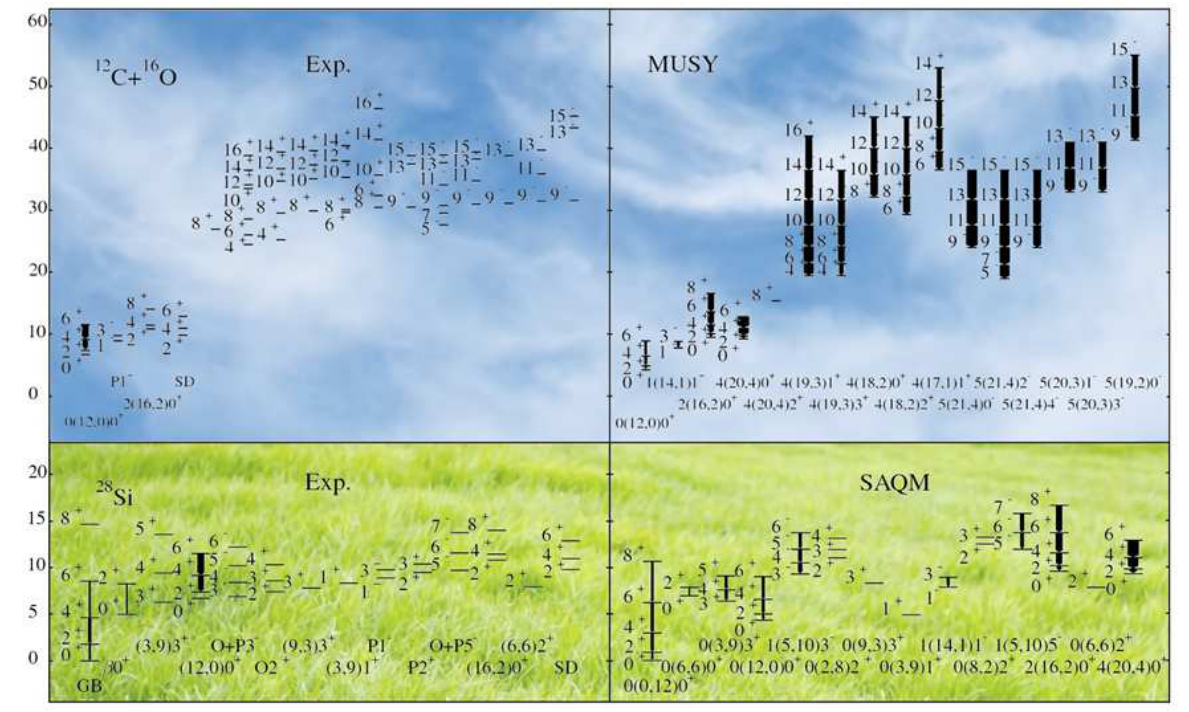
Figure 2. (Color online) Description of the low-energy bands of the 28 Si nucleus in terms of the semimicroscopic algebraic quartet model (lower part in the grass field), and the prediction of the MUSY for the 12 C + 16 O cluster spectrum (upper right part in the clouds) in comparison with the experimental spectrum of the 12 C + 16 O molecular resonances (upper left